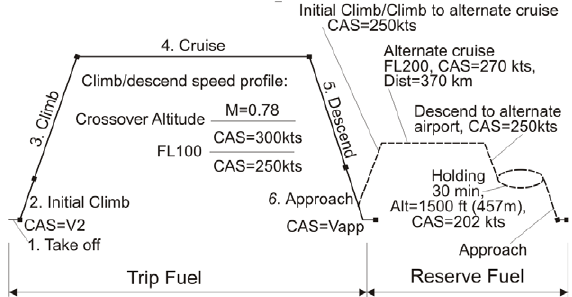
Figure 2. Elements of the simulated flight